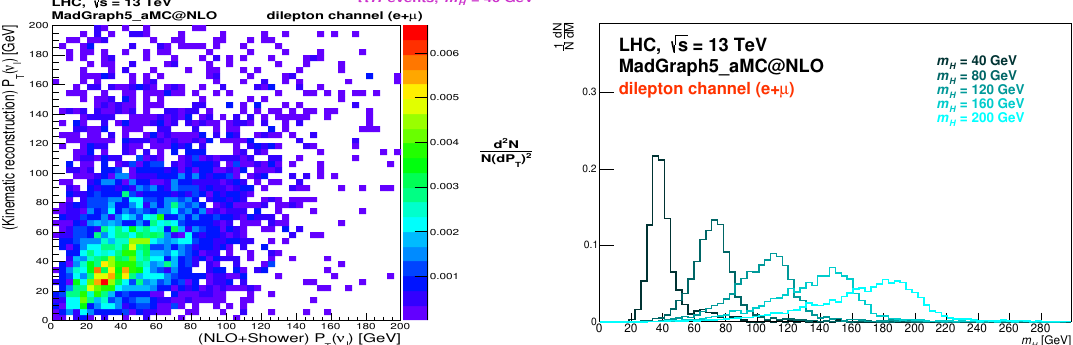
Figure 12. Two-dimensional distribution of the neutrino p T in t (cid:22) tH events (left): the NLO+Shower p T (x-axis) against the reconstructed p T (y-axis) is shown. Distribution of the reconstructed Higgs boson mass with truth-matched jets in t (cid:22) tH events (right).